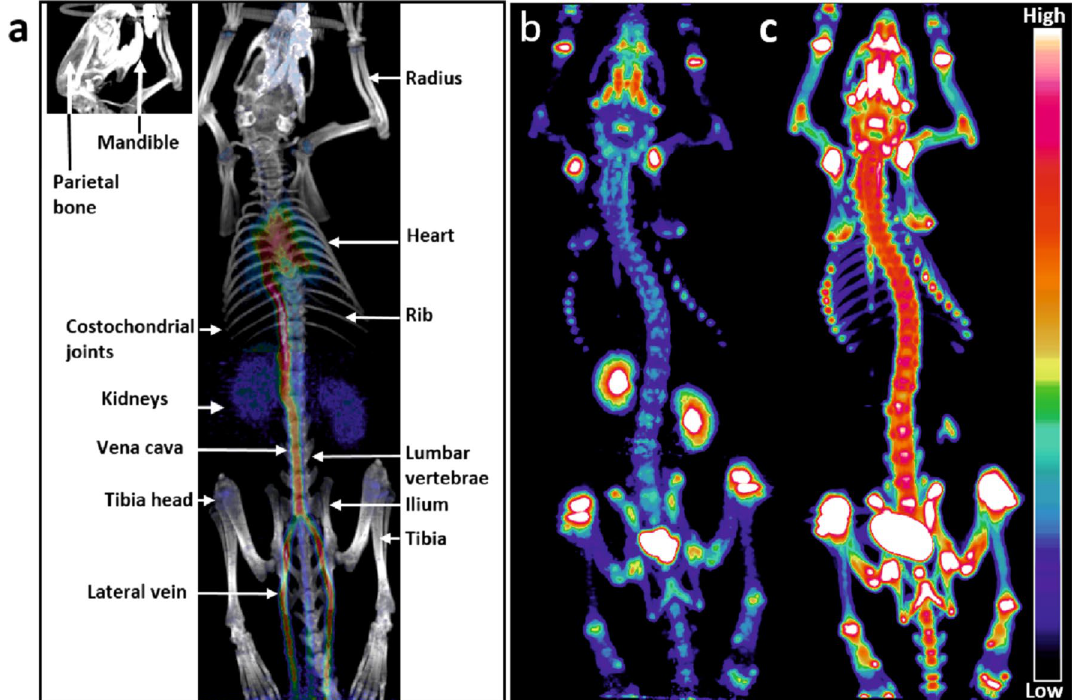
Fig. 1 Fused anterior 3D PET/CT image acquired at 0–30 s and PET images acquired at 1–5 min and 20–50 min show the in vivo biodistribution of [ 18 F]fluoride in male Sprague Dawley rats (the images present the same rat but from two different imaging sessions). a At 0–30 s, the highest uptakes are observed in the caudal vein, vena cava, heart, and kidneys. b At 1–5 min after the injection, uptake appears in the kidneys, bladder, and epiphyseal regions of long bones, mandible, and costochondral joints. c At 20–50 min, uptake is decreased in the kidneys but elevated in the bones and